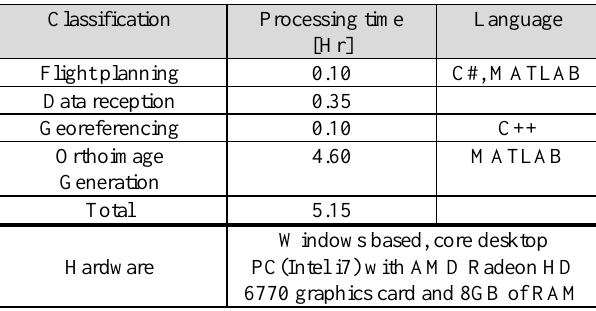
Table 4. Processing time & Hardware